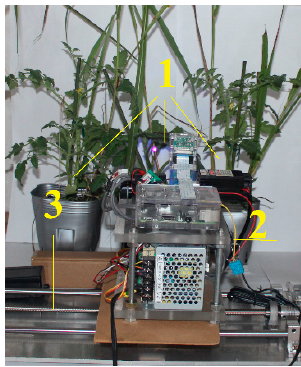
Figure 8. The experimental setup with E. repens between tomato plants. 1 . Elytrigia repens plant; 2 . the laser installation; 3 . the device was allowing the laser to move horizontally.